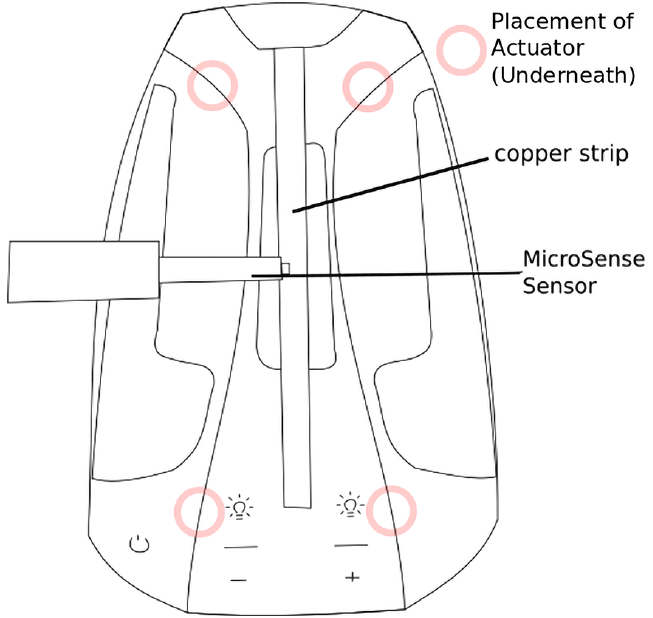
Figure 6. Sketch of the control panel with overlaid adhesive copper tape and MicroSense Sensor po-